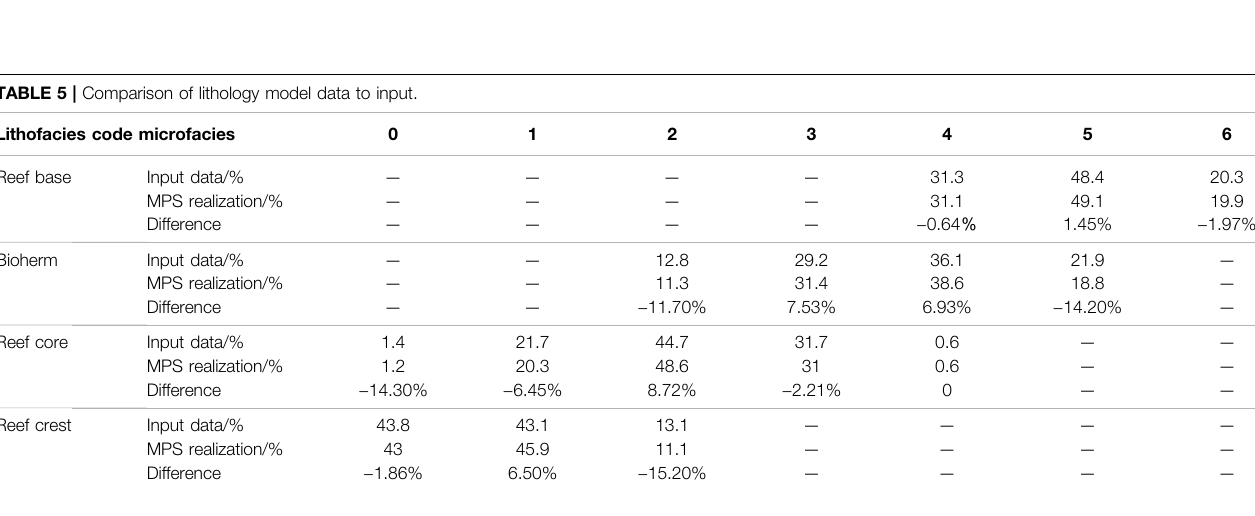
TABLE 5 | Comparison of lithology model data to